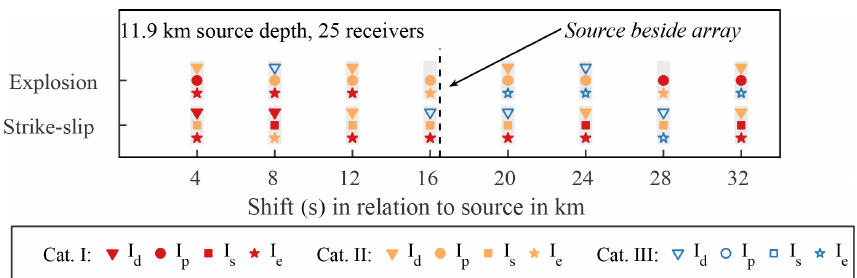
Figure 8. The location accuracy achieved using 25 stations instead of 9 stations placed 8km apart while shifting the array. The dotted line denotes the point at which the array is no longer above the source. A source at a depth of 11.9km was tested with two source types. The locations obtained with the individual imaging conditions were ranked according to the categories from Fig. 2. Grey bars indicate set-ups that were tested. No symbol in the grey bar means the localisation was unsuccessful. Symbol types and colours in the grey bars represent successful locations with the imaging condition sorted into the respective